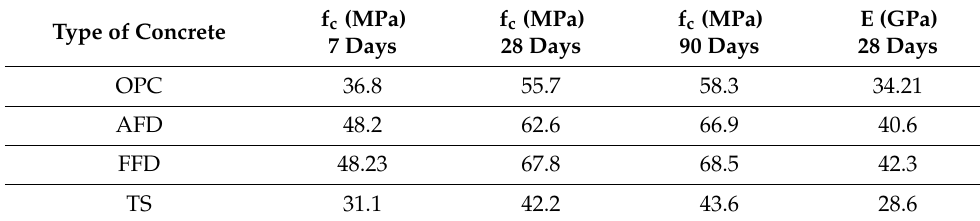
Table 4. Compressive strength. Type of Concrete